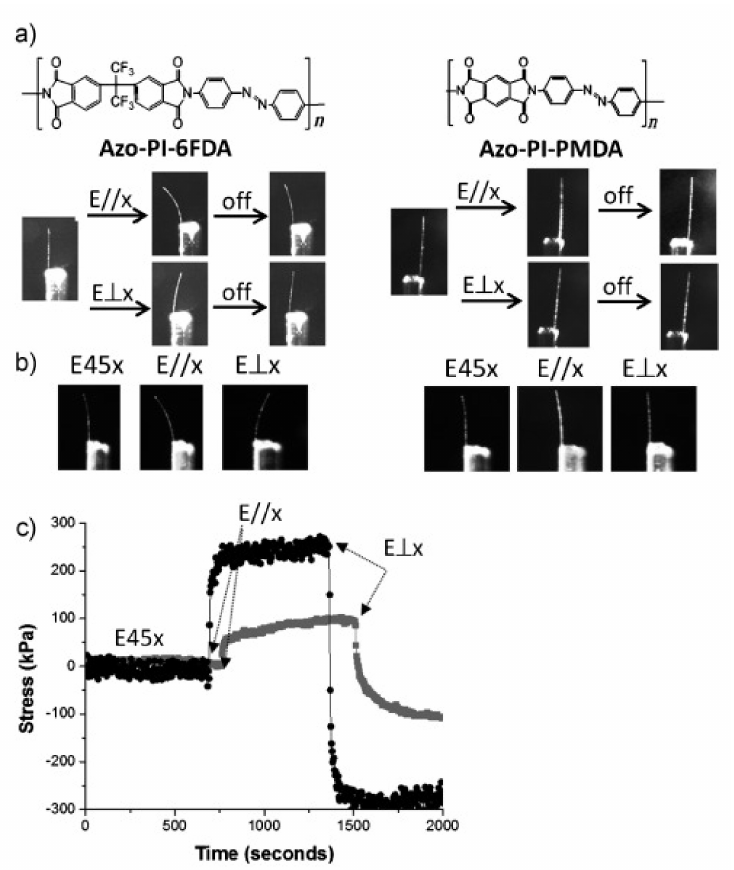
Figure 13. Polarization − dependent photomechanical response of Azo-PI-6FDA upon irradiation with 100 mW cm − 2 of λ = 442 nm light ( a ) and Azo-PI-PMDA upon irradiation with 100 mW cm − 2 of λ = 488 nm ( b ). The light was polarized parallel to the long axis (E//x) of the 5 mm × 0.5 mm × 0.02 mm cantilever and orthogonal to the long axis of the cantilever (E ⊥ x). ( c ) The tensile stress generated from Azo-PI-6FDA ( • ) and Azo-PI-PMDA ( (cid:4) ) upon irradiation with 100 mW cm − 2 of λ = 457, 488, and 514 nm multiline output from an Argon ion laser is examined during continuous irradiation to linearly polarized light oriented 45 ◦ , parallel, and orthogonal to the long axis of the 6 mm × 1 mm × 0.02 mm gauge. Reprinted with permission from Reference [72]. Copyright 2012